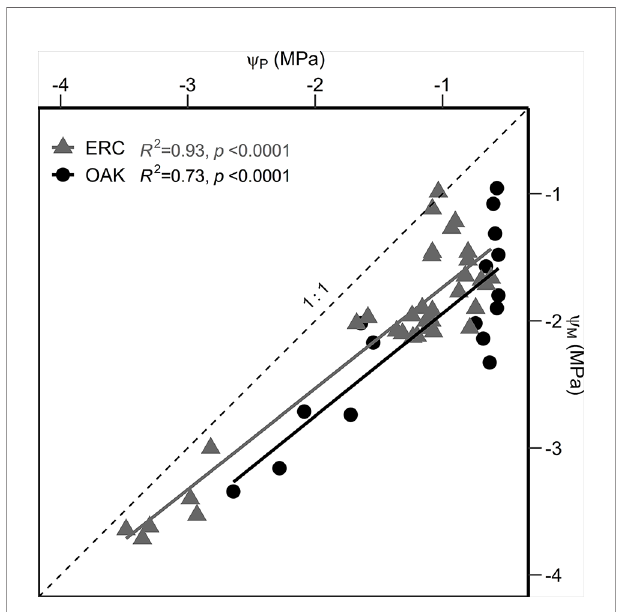
FIGURE 6 | Linear regressions between the predawn water potential ( Y P ) and midday water potential ( Y M ) for post oak (circles) and eastern redcedar (triangles). The 1:1 relationship is indicated by a dashed line. Equations are as follow: Y